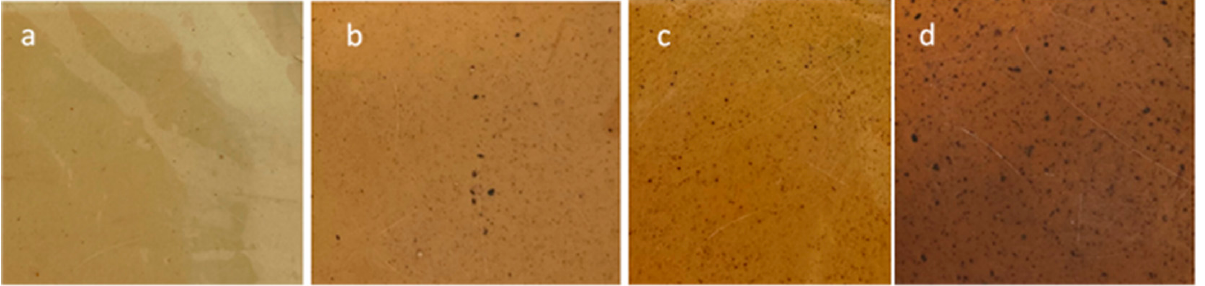
Figure 4. Visual appearance of the films (40 × magnification) of ( a ) CH 2% film; ( b ) CH 2% + OLE 10% film; ( c ) CH 2% + OLE 20% films; ( d ) CH 2% + OLE 30% film.